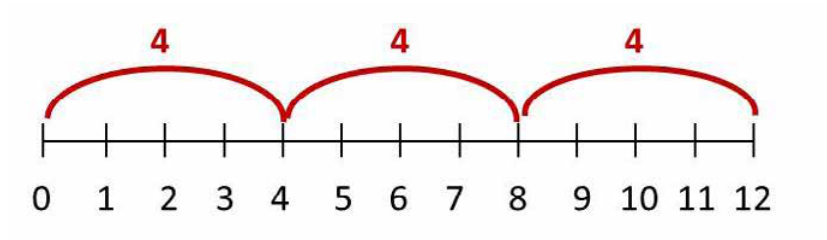
Figure 6: Bundling and unbundling (bundles of